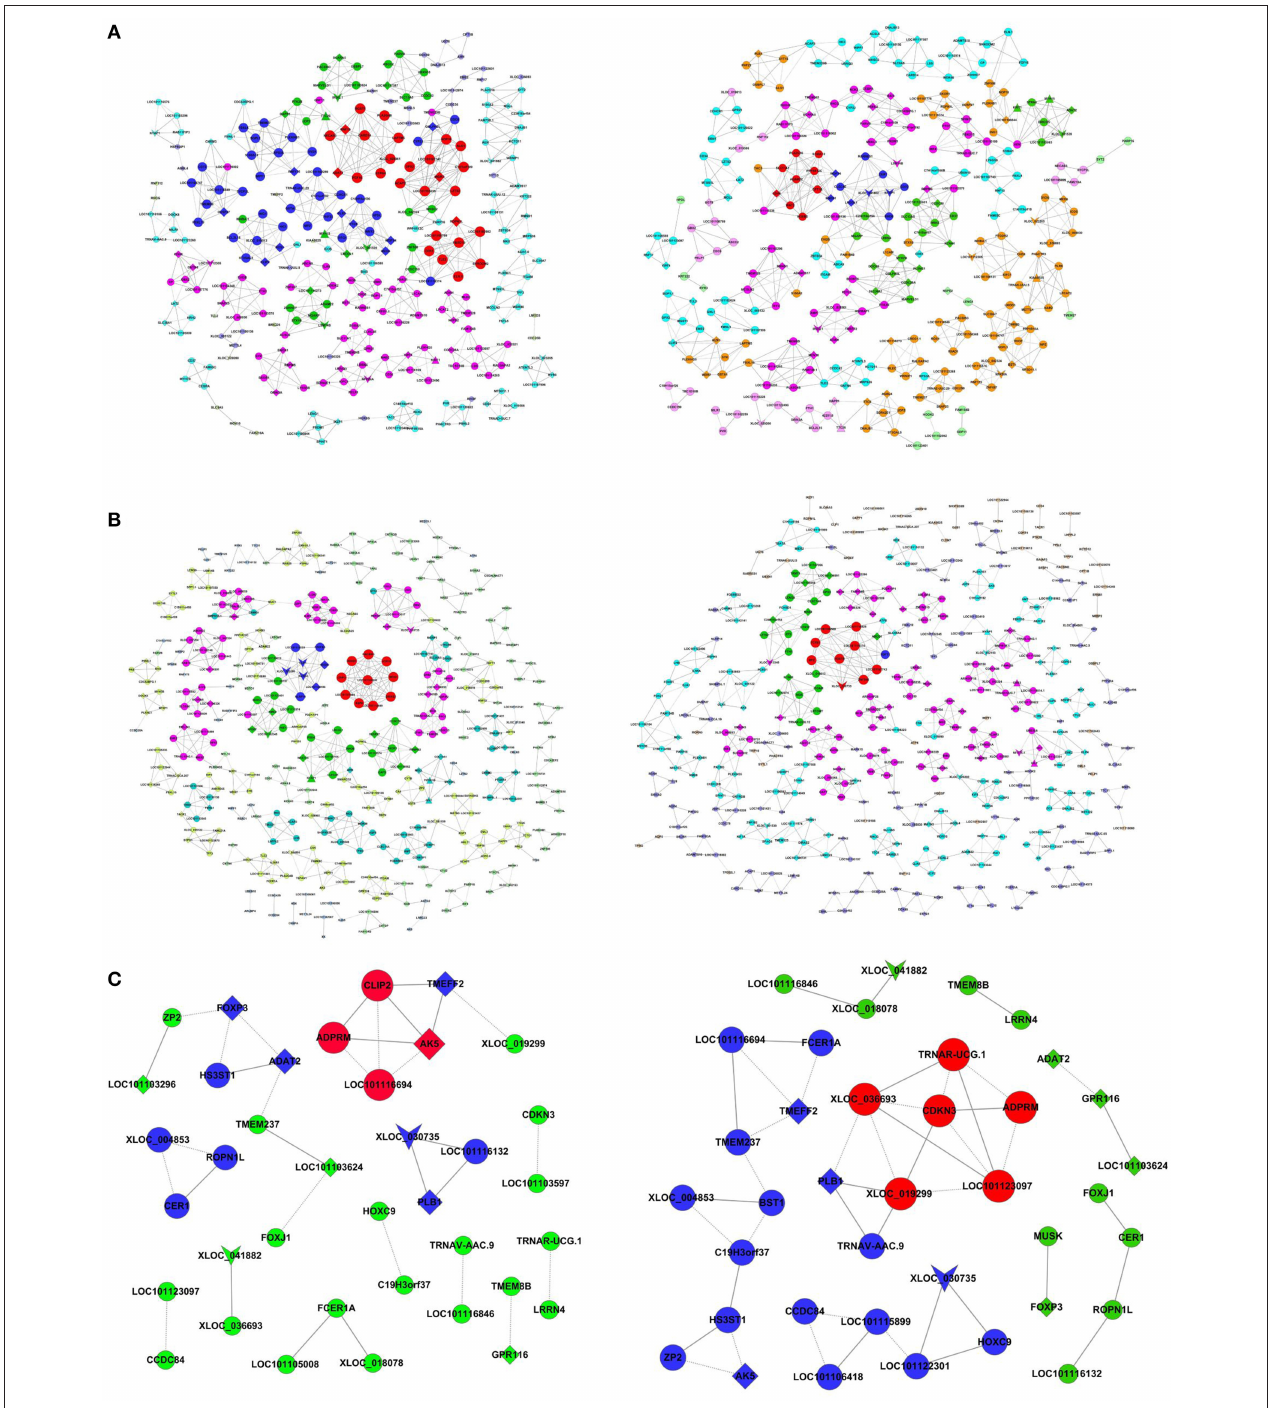
FIGURE 3 | Co-expression networks of the fecundity-associated genes and the co-regulated lncRNAs. (A–C) illustrates the networks derived from the samples (left) and the control group (right). (A) Han BB vs. Dorset; (B) Han ++ vs. Dorset; (C) Han BB vs. Han ++ . Han BB, Small Tail Han ewes with the genotype BB (HanBB) and genotype ++ (Han ++ ); Dorset, Dorset sheep. The inverted triangle denotes the lncRNA, and the triangle denotes the methylated genes encoding the lncRNA. The circle denotes the mRNA, and the diamond denotes the methylated genes encoding the mRNA. The nodes with the same color represent the genes with a similar co-expressing ability. The node size represents the node